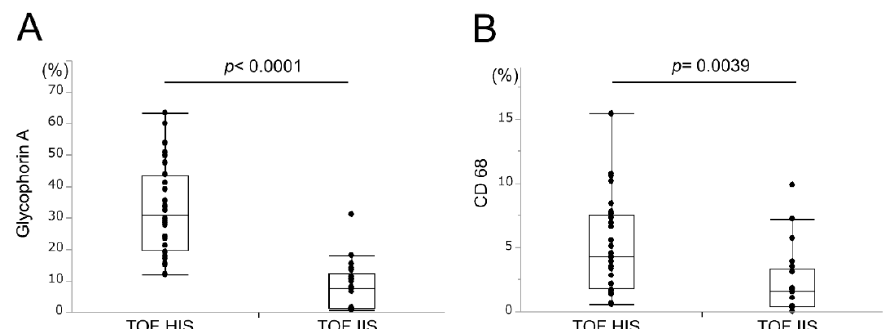
Figure 1. Relationships between time-of-flight magnetic resonance angiography (TOF-MRA) signal intensity and ( A ) glycophorin A-positive area and ( B ) CD68-positive area. The glycophorin A and CD68-positive areas are significantly larger in the TOF-HIS group (high-intensity signal plaques) than in the TOF-IIS (iso-intensity signal plaques) group. p -values are based on the Student’s t-test.